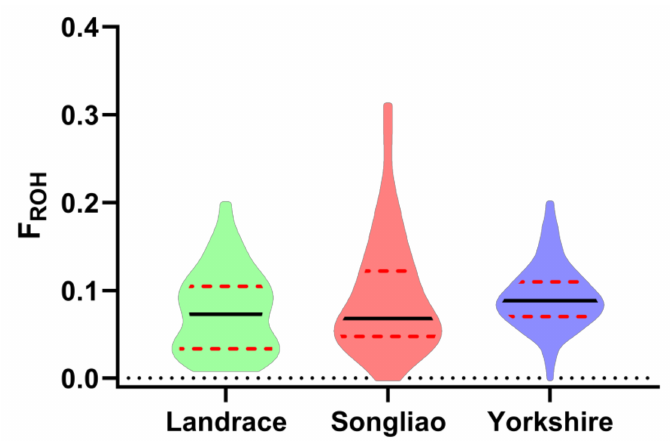
Figure 4. Distribution of runs of homozygosity inbreeding coe ffi cients within each breed.